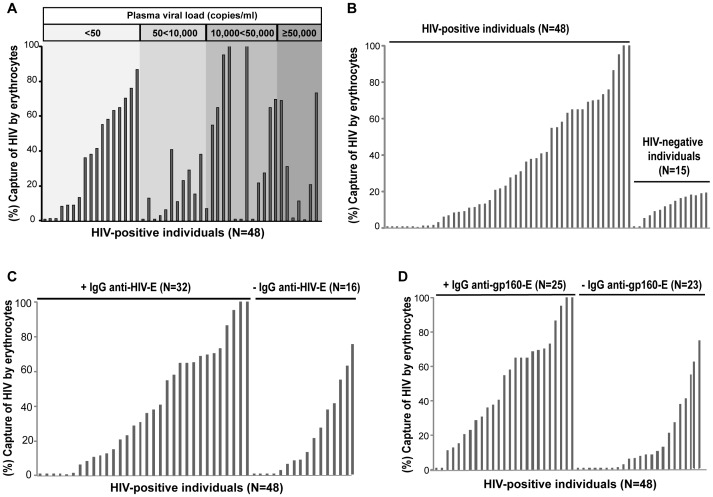
Capture of HIV by erythrocytes from HIV-positive individuals.Plots show capture of HIV by erythrocytes (percentage of p24-antigen bound to erythrocytes, viral capture assay) from 48 HIV-positive individuals (48 of 75 belonging to Table S1) and 15 HIV-negative individuals. Each bar represents an individual. (A) HIV capture by erythrocytes according to plasma viral load. Range of plasma viral load is indicated at the top. Individuals are located according to the value of plasma viral load at the time of study. No correlation is observed between the ability of HIV capture by erythrocytes and plasma viral load of patients (rho = 0.022, p = 0.8817, correlation was evaluated using Spearman’s rank correlation), demonstrating that viral capture by erythrocytes occurs independently of plasma viral load. (B) HIV capture by erythrocytes from 48 HIV-positive and 15 HIV-negative individuals. Individuals are located in increasing values of viral capture capacity. Both groups show a significant difference between mean levels of HIV capture (p<0.0001). (C) The 48 HIV-positive individuals are grouped according to the presence (+ IgG anti-HIV-E, N = 32) or absence (- IgG anti-HIV-E, N = 16) of at least one IgG anti-HIV associated to erythrocytes. No statistical difference was found between presence of IgG anti-HIV-E and a viral capture >20% by erythrocytes (p>0.5). (D) The 48 HIV-positive individuals are grouped according to the presence (+ IgG anti-gp160-E, N = 25) or absence (- IgG anti-gp160-E, N = 23) of IgG anti-gp160 associated to erythrocytes. Erythrocytes with presence of IgG anti-gp160 show an HIV capture higher than 20% (p<0.0005).